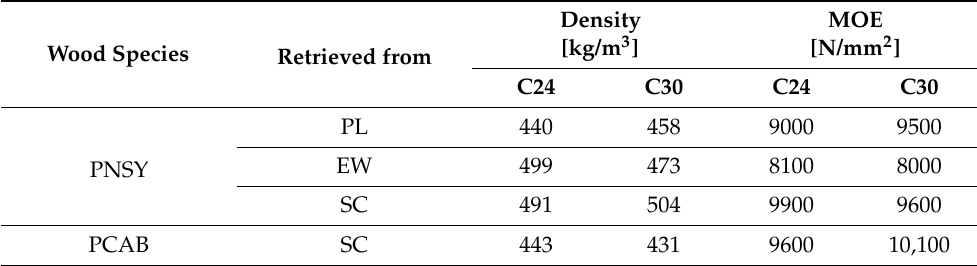
Table 2. Material data used in the analysis of numerical models of B version long frames made of glued material.